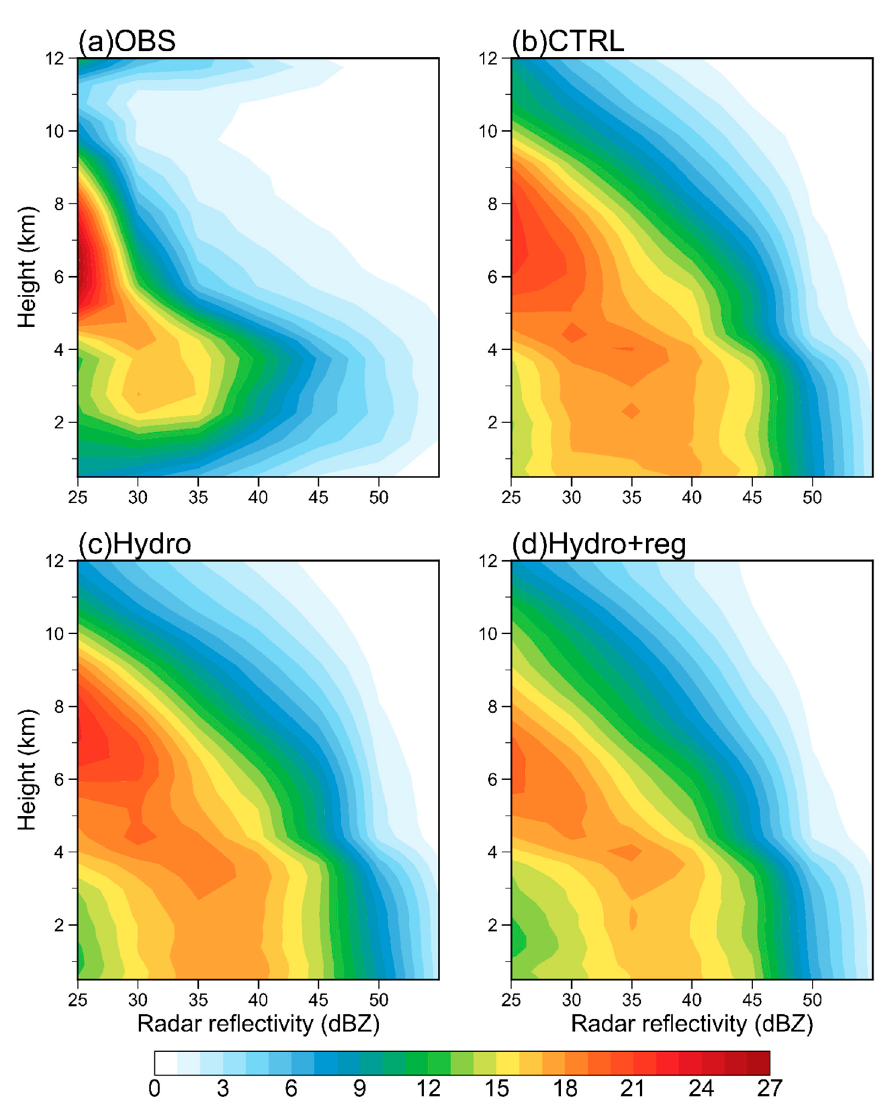
Figure 14. Contoured Frequency by Altitude Diagrams (CFADs, shaded, units: %) in main precipitation areas at 0920 UTC from ( a ) Observation, ( b ) CTRL, ( c ) Hydro and ( d ) Hydro+reg experiments after 3 cycles. The CFADs is calculated over the main precipitation area (29 ◦ –35 ◦ N, 115 ◦ –123 ◦ E; blue box in Figure